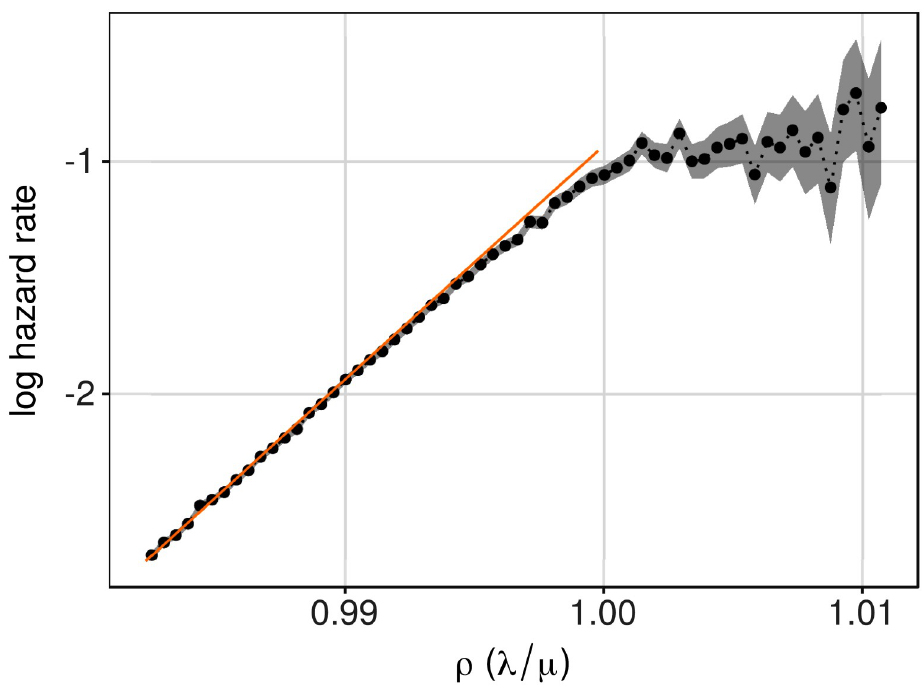
Fig 4. Hazard rates as a function of ρ , i.e., ( λ / μ ), close to 1. The dashed region represents 95% confidence intervals (from a Poisson approximation), and the orange line represents predictions from the theory (Eq 6). Model parameters were: λ = 540, μ 0 = 550, β = 0.52/365, θ = 100, and 4.0 × 10 5 realizations of the systems were run.